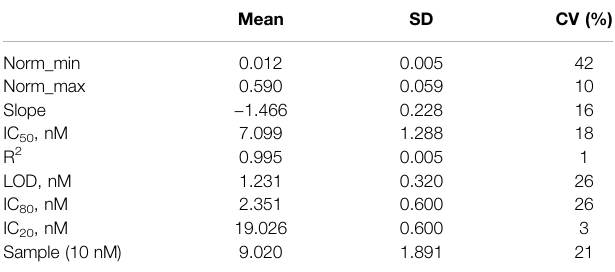
TABLE 1 | Analytical features from the fl uorescent microarray calibration curve for A2BSA/As233 assay using as IS 13BSA/As138 (N = 8). Quanti fi cation of sample at 10 nM (N = 4) is